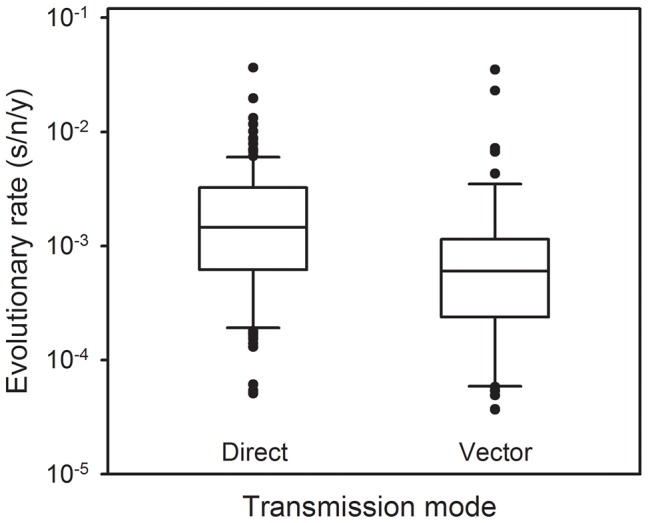
Molecular evolution of directly transmitted and arthropod-transmitted riboviruses.Data were collected from the supplementary information of a previous meta-analysis [69] and include 170 evolutionary rates, 113 for directly transmitted viruses and 57 for arboviruses. The box plot indicates the median (central lines), percentiles 25/75 (box) and percentiles 10/90 (bars), and outliers (dots).